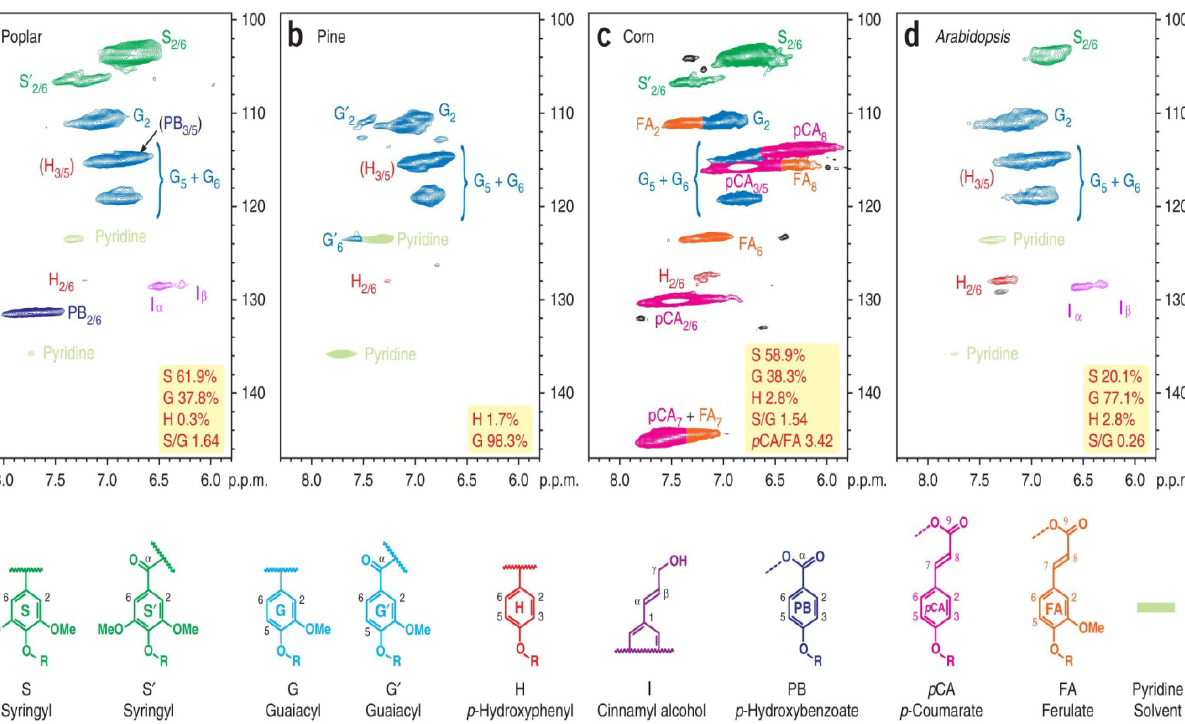
Figure 14. 2D-HSQC NMR spectra revealing lignin unit compositions. 2D-HSQC spectra (aromatic regions only) of cell wall gels in 4:1 (vol/vol) DMSO- d